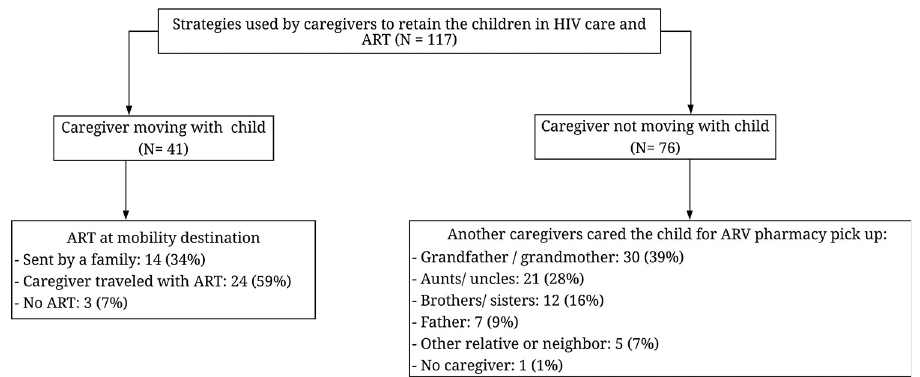
Fig 2. Strategies used by caregiver s to retain their children in HIV care and ART among those with mobility history.